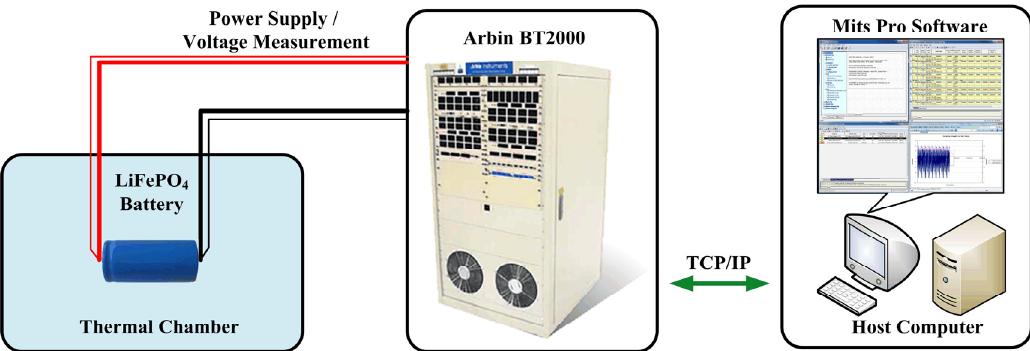
Figure 2. Schematic of the battery test bench.